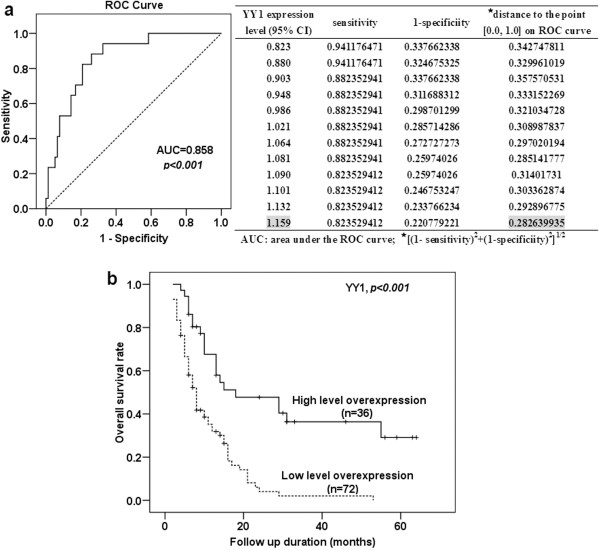
Correlation between YY1 expression and patient survival. (a) ROC curve for YY1 expression and cut-off value selection for high and low level YY1 expression. (b) Kaplan-Meier survival curves in 108 patients with PDAC according to their YY1 mRNA expression status. The p value was calculated by the Log-rank test.